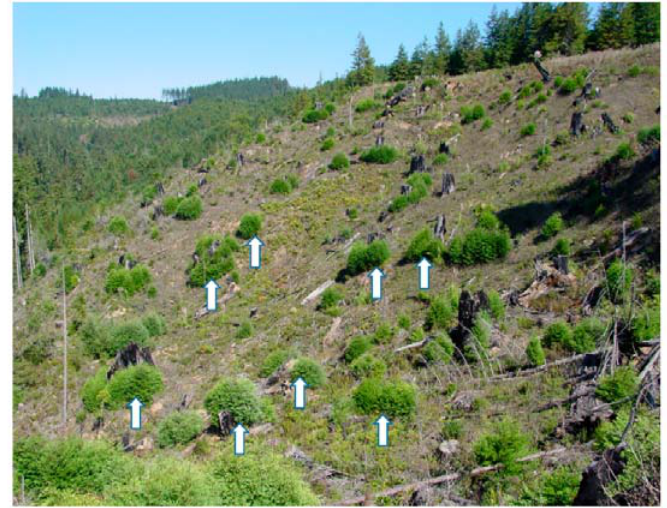
Figure 3. Two ‐ year ‐ old clearcut showing redwood sprout clumps (some of which are indicated with Figure 3. Two-year-old clearcut showing redwood sprout clumps (some of which are indicated with arrows) and spaces between them. Photograph taken in Humboldt County, CA, USA. arrows) and spaces between them. Photograph taken in Humboldt County, CA,